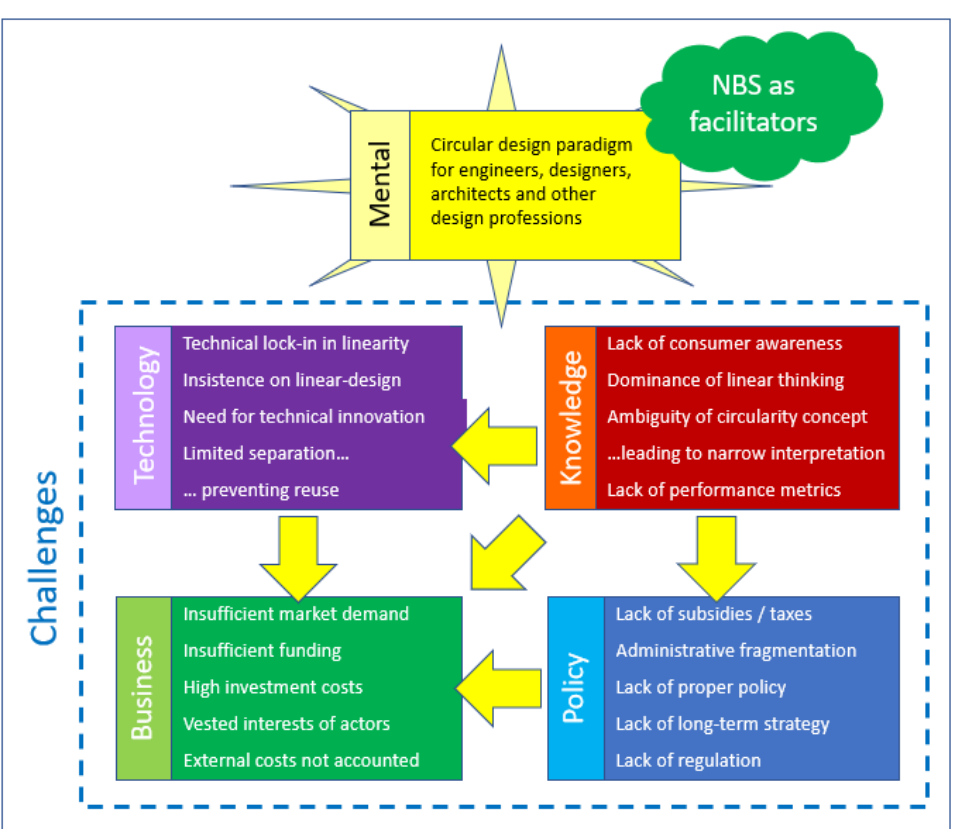
Figure 1. Challenges to the implementation of circularity in urban areas [6] and the critical role of the mental category—a new circular design paradigm—to address them, using nature-based solutions as facilitators.